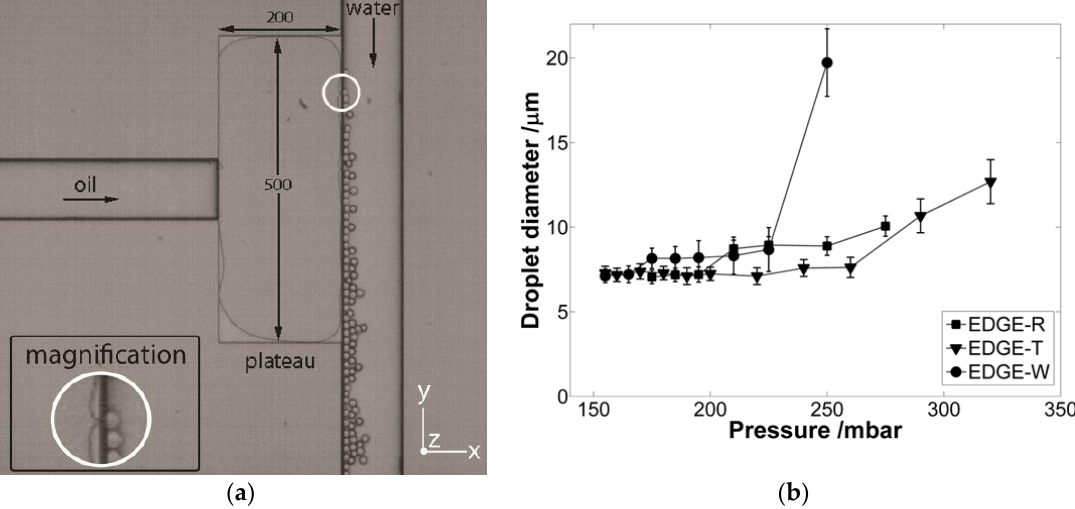
Figure 2. ( a ) Top view of an EDGE device; the oil is pushed from the left onto the plateau, which is a shallow area of two micrometer. Upon reaching the deeper channel on the right, the oil droplets are generated over the entire length of the plateau [39]; ( b ) pressure dependency of EDGE devices; droplet formation starts at the minimum pressure, and the droplet size remains constant till the blow-up point is reached at which the droplet size shoots up, and the droplets become polydisperse [40].